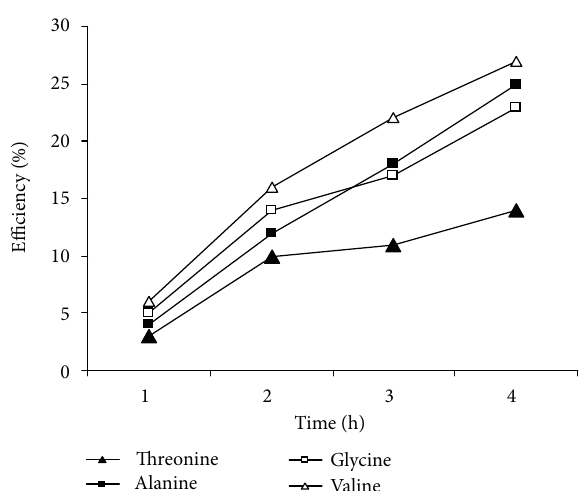
F 6: Efficiency of amino acids back extracted aer 4h with krypto�x 5. Concentration of amino acid in source phase = M. Concentration of krypto�x 5 = −3 10